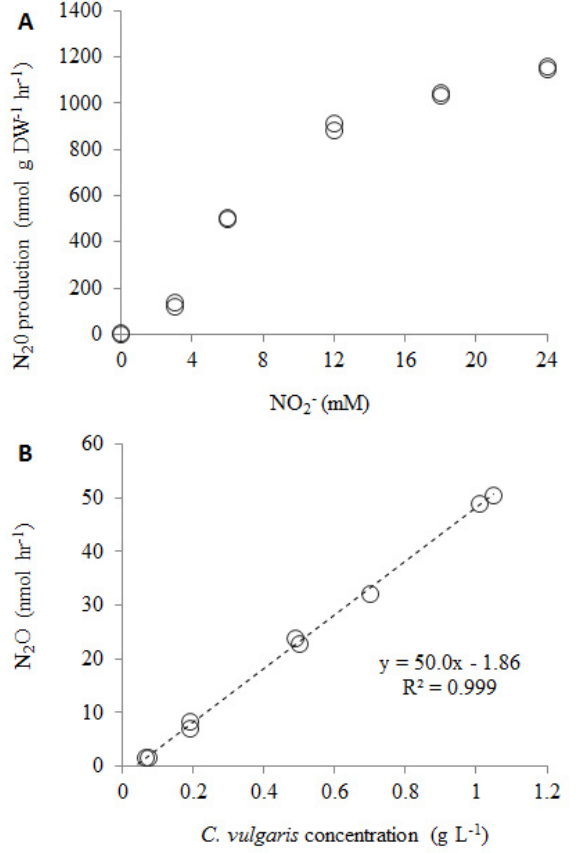
Fig. 4. Influence of nitrite concentration (A) and C. vulgaris concen- tration (B) on specific N 2 O production from C. vulgaris cultures in- cubated in darkness ( n = 2). When nitrite concentration was varied, C. vulgaris concentration was 0.58gL − 1 , when algae concentra- tion was varied, nitrite concentration was 12mM. The rates shown represent data from duplicates (e.g. not the average) and were de- termined between 1.5 and 3.5h after nitrite addition